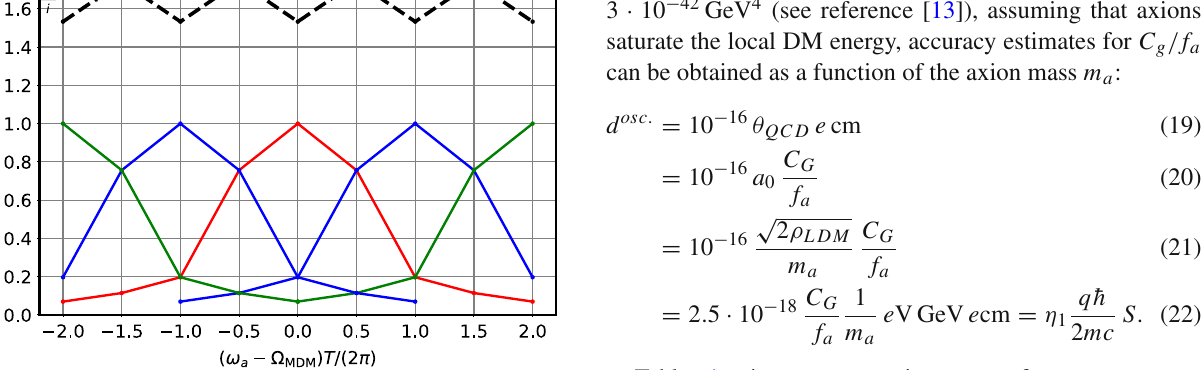
Fig. 3 Figure of merit (FOM) as a function of (ω a − Ω MDM ) T /( 2 π) normalized to the FOM at resonance Δω = (ω a − Ω MDM ) = 0. Solid lines: FOM for measurements at Δω T /( 2 π) = − 2 , − 1 , 0 , 1 , 2 respec- tively. Dashed line: sum of FOMs